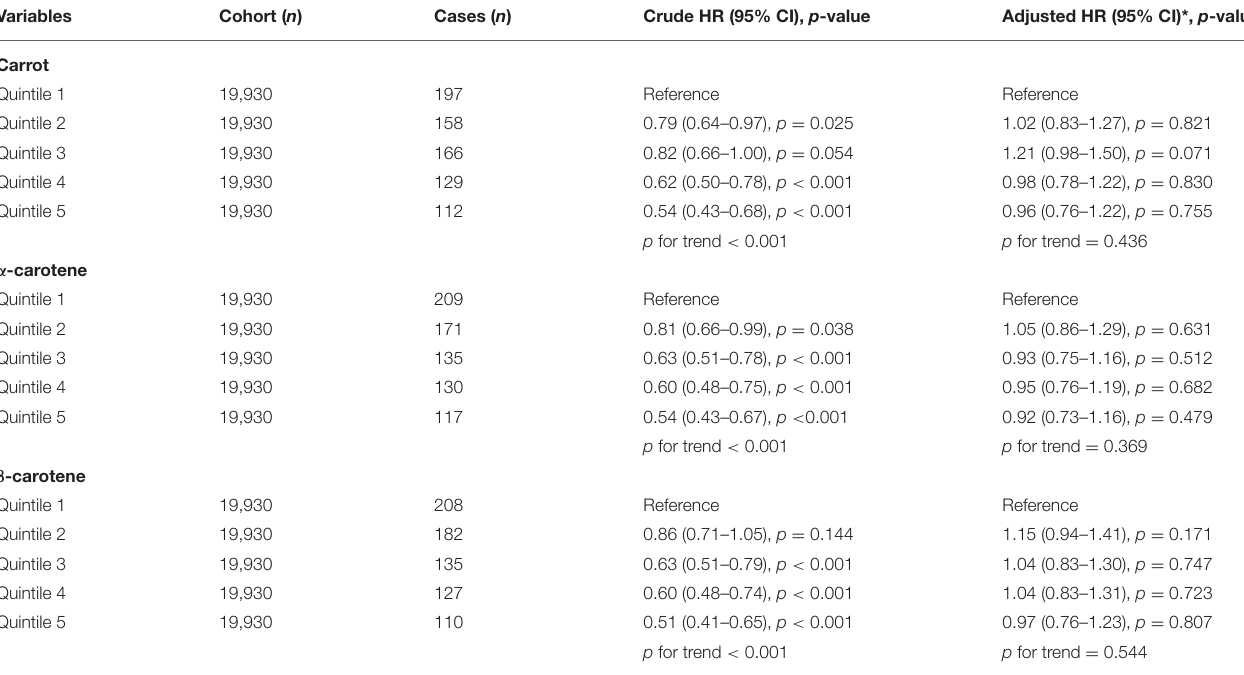
TABLE 2 | Association between energy-adjusted intake of carrot/carotene and bladder cancer risk in the PLCO cancer screening trial. Variables